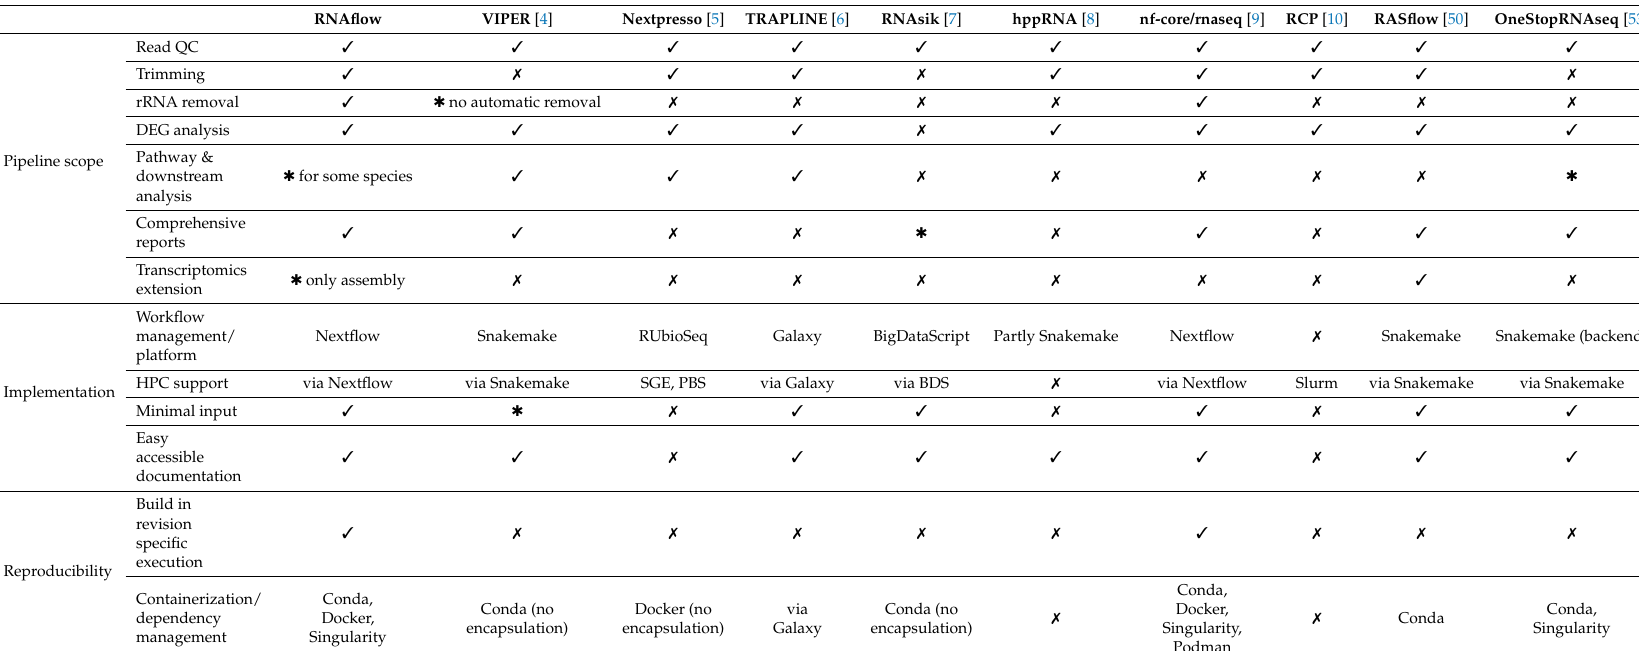
Table A1. Comparison of features in RNAflow with other RNA-Seq pipelines. (cid:51) —feature available/supported; (cid:55) —feature not available/supported; (cid:81) —feature partially